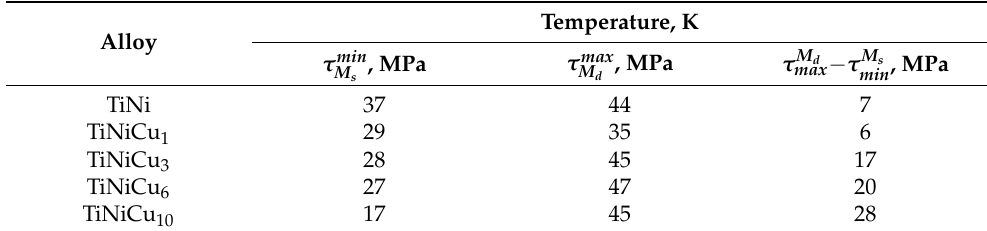
Table 3. Minimal and maximal martensitic transformation stresses of porous TiNi alloys with copper